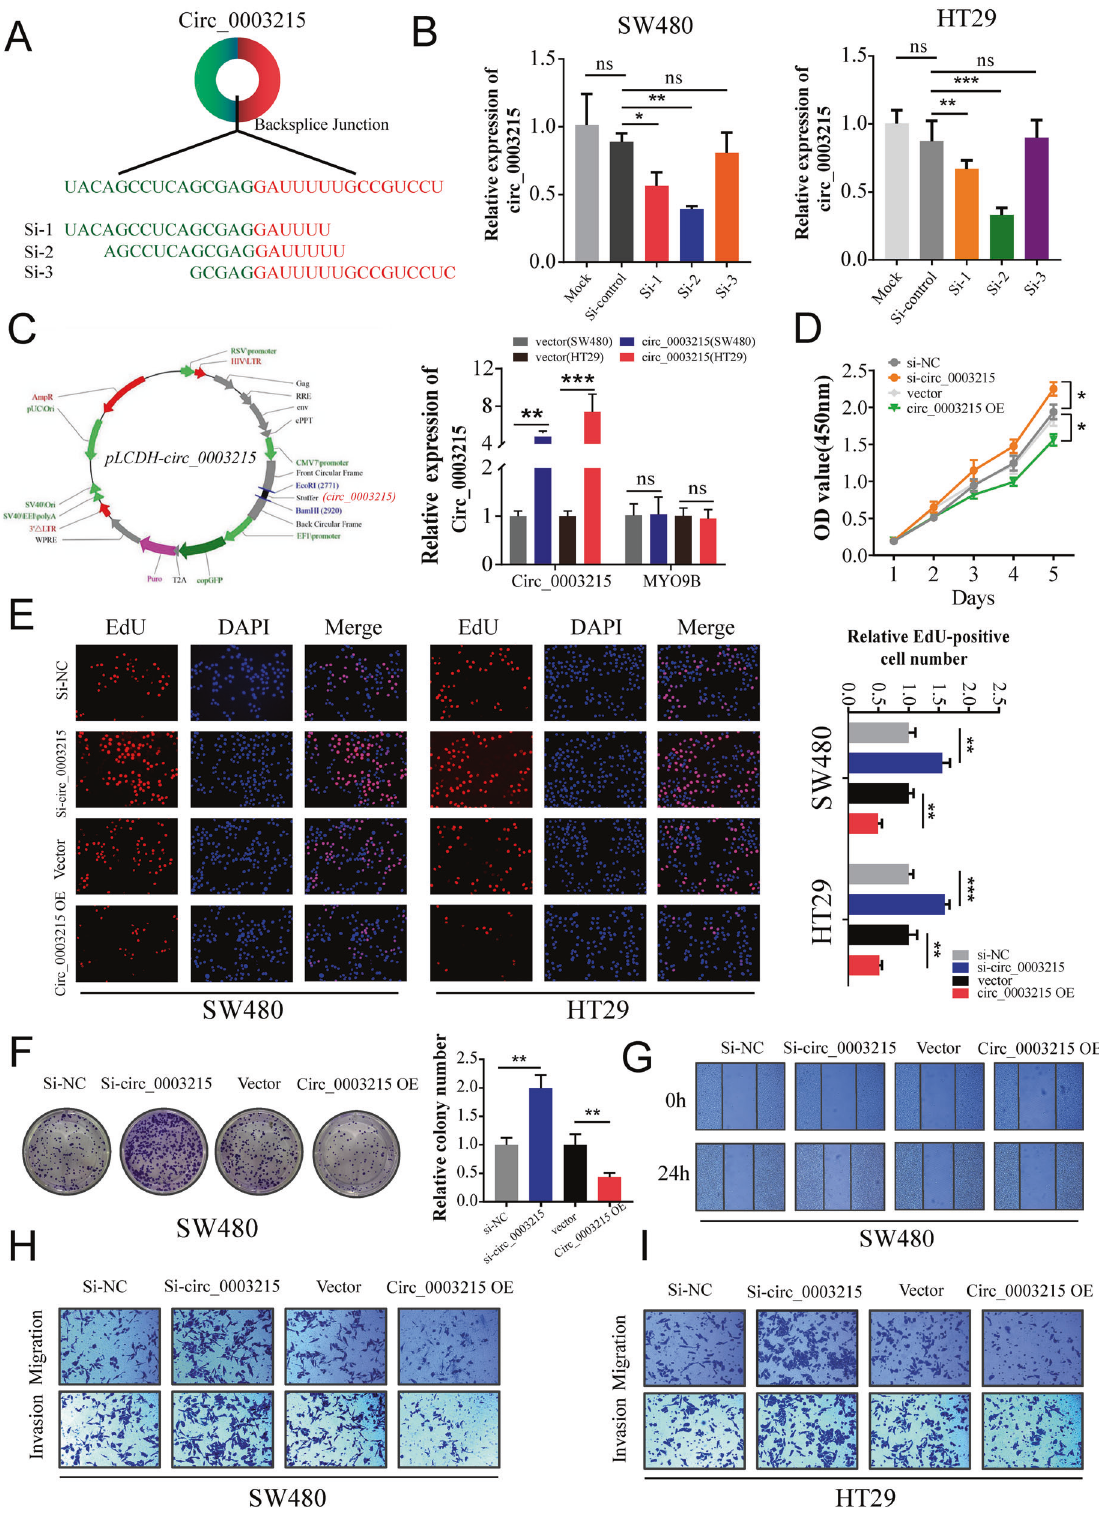
Fig. 3 Circ_0003215 supresses CRC cell proliferation, invasion and migration. A Schematic illustration of three siRNAs was designed to target the back-splicing junction site of circ_0003215. B Knockdown ef fi ciency of three siRNAs in SW480 and HT29 cells. Si2-circ_0003215 has the highest knockdown ef fi ciency. C Schematic graph of the pLCDH-circ_0003215 plasmid constructs(left). The relative expression of circ_0003215 or MYO9B was detected by RT-qPCR after treatment with empty vector or pLCDH-circ_0003215 in CRC cells(right). D , E The cell proliferative effects of circ_0003215 were evaluated in SW480 and HT29 cells by CCK-8 and EdU assays. F Colony formation assay of SW480 cells transfected with control, circ_0003215 siRNA, vector or pLCDH-circ_0003215. G The effect of circ_0003215 on the migration of SW480 cells was detected by wound healing assay. H , I The effect of circ_0003215 on the migration and invasion of CRC cells were evaluated by transwell assay. Graph shows mean ± SD; * P < 0.05, ** P < 0.01, *** P < 0.001. Cell Death and Disease